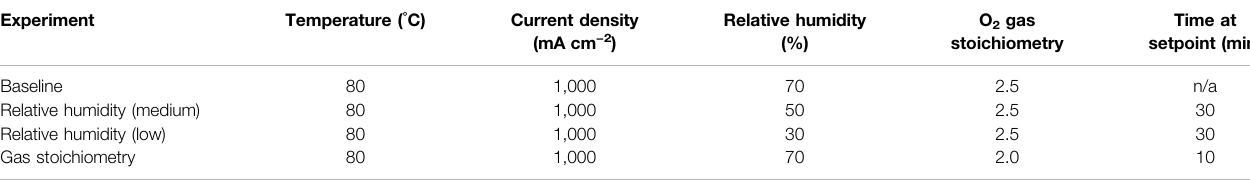
TABLE 1 | Table of experimental parameters used in this work.